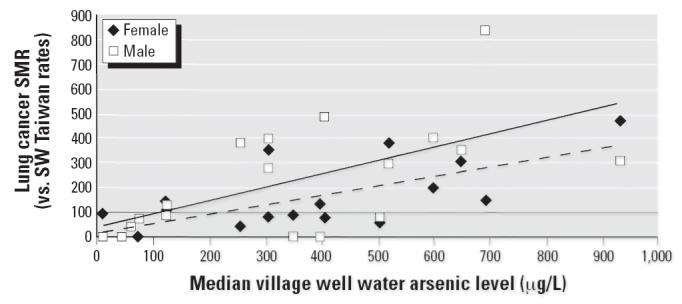
Lung cancer SMRs for township group 2, 4, 6 for male and female by median
village well water arsenic level (μg/L). Male lung cancer: y = 0.536x + 37.5; R2 = 0.40; p = 0.003. Female lung cancer: y = 0.371x + 19.4; R2 = 0.52; p < 0.001.